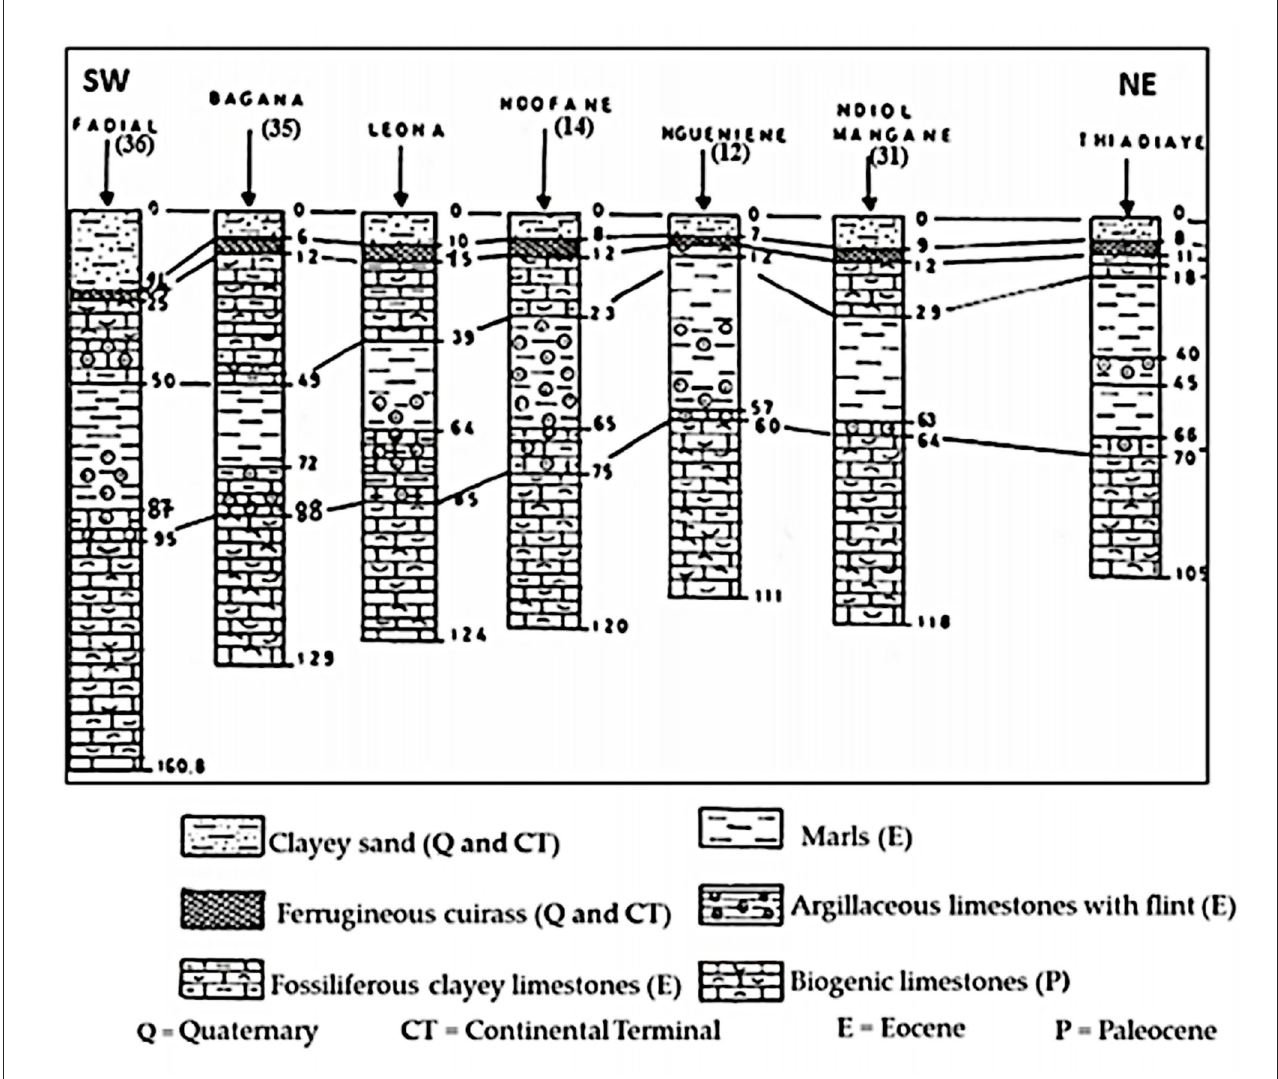
FIGURE2 Geological cross section from Fadial to Thiadiaye (Sarr, 1999), modified. (Location of cross section is indicated in Figure 1).